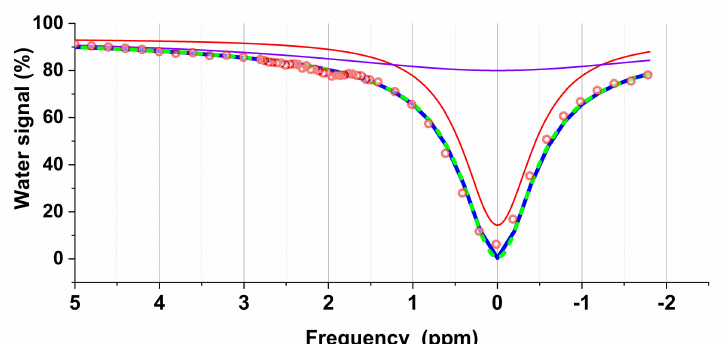
Figure 1. The background curve (blue) is generated by two Lorentzian functions, which include direct saturation of water molecules (red) and the magnetization transfer (MT) (purple), respectively. This background signal also consists of the one simulated by Equation (4) (cyan dash